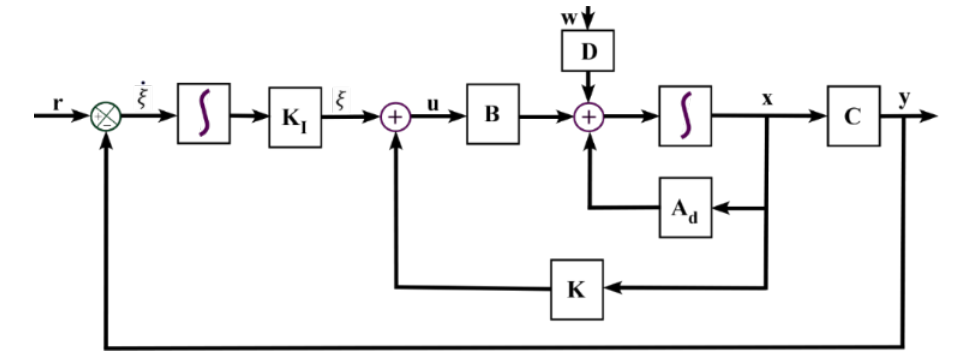
Figure 3. Tracking system.